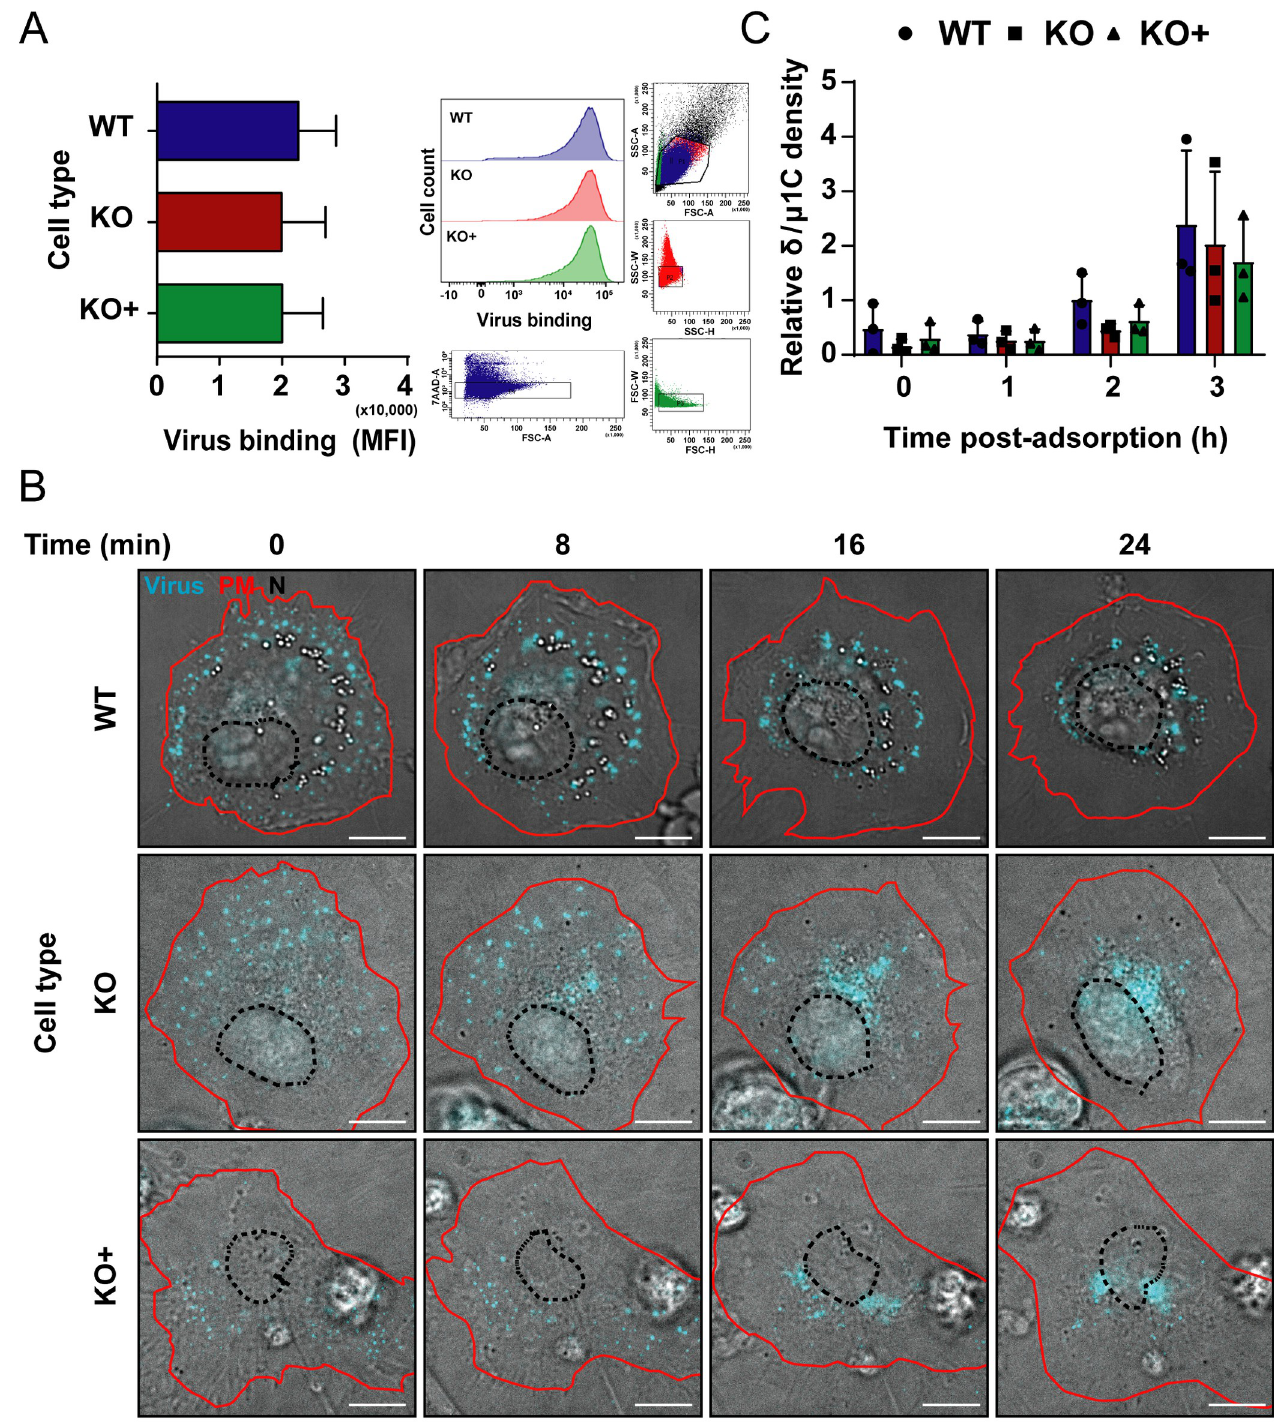
Fig 3. Binding, internalization, and uncoating are not disrupted by cholesterol accumulation in NPC1 KO HBMECs. (A) WT, KO, and KO+ HBMECs were adsorbed with Alexa 647 labeled-reovirus virions at an MOI of 10,000 particles/cell at 4˚C for 1 h, fixed with 1% PFA, and analyzed for virus binding using flow cytometry. The results are presented as mean virus binding as determined by mean fluorescence intensity (MFI) of three independent experiments. Error bars indicated standard deviation. Gating strategy plots and a representative histogram are shown. (B) WT, KO, and KO+ HBMECs were adsorbed with Alexa 647 labeled-reovirus virions (cyan) at an MOI of 10,000 particles/cell at 4˚C for 45 min and imaged using high magnification live-cell imaging, with images captured every * 25 seconds. Representative micrographs from videos at the indicated intervals are shown. Scale bars, 10 μ m. Labeling for plasma membrane